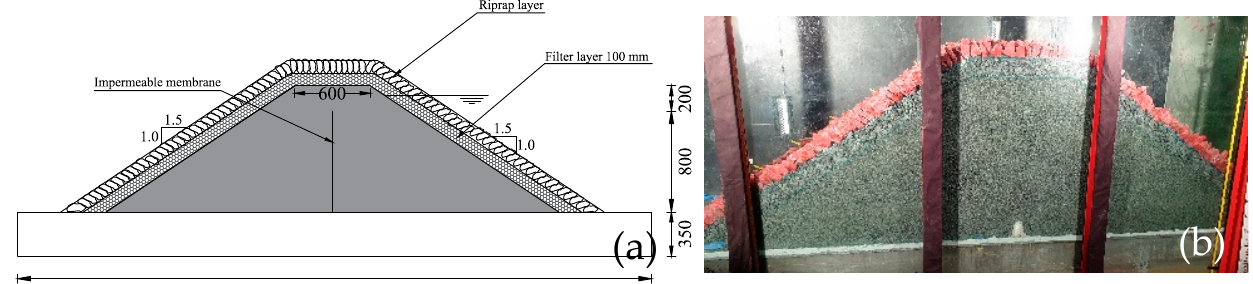
Figure 8. ( a ) Depiction of experimental setup of full dam model with flexible core, and ( b ) image of placed riprap model with such a setup.